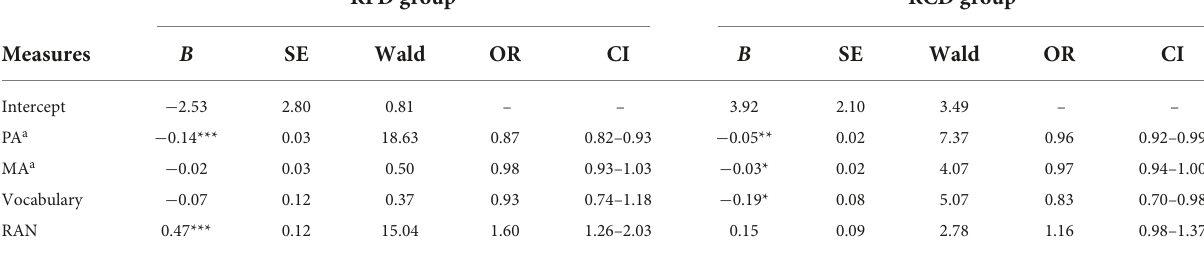
TABLE 6 Results of multinomial logistic regression predicting children’s type of RD. RFD group RCD